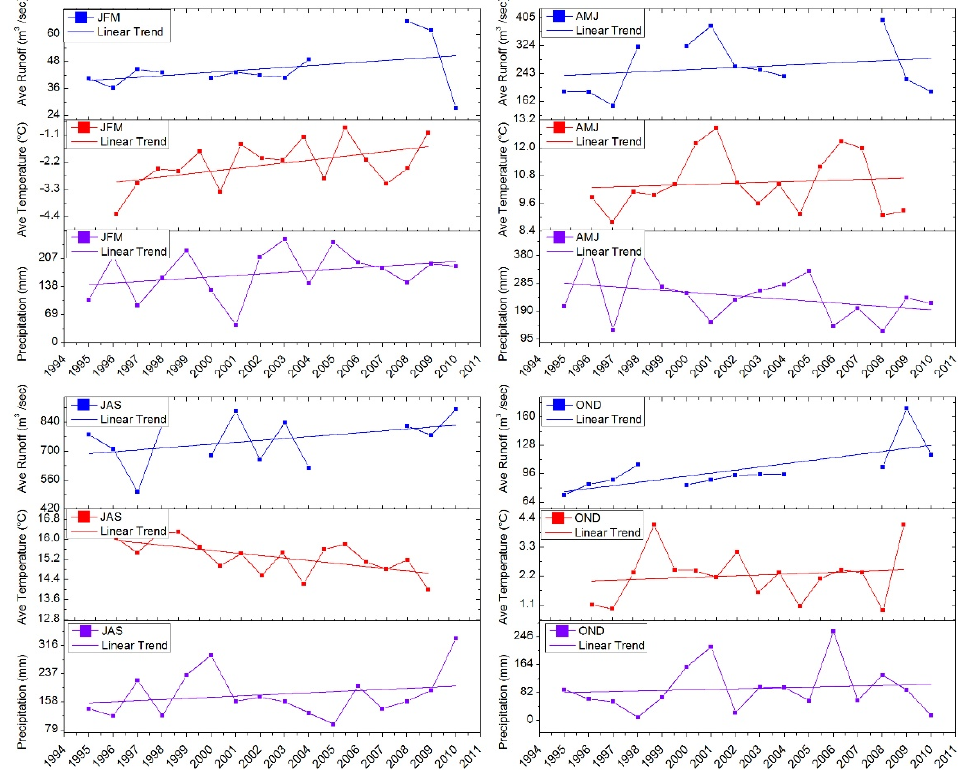
Figure 7. Comparison among the recorded hydrological and meteorological data during the 1995–2010 period; grouped as JFM (January, February, March), AMJ (April, May, June), JAS (July, August, September), and OND (October, November, December).